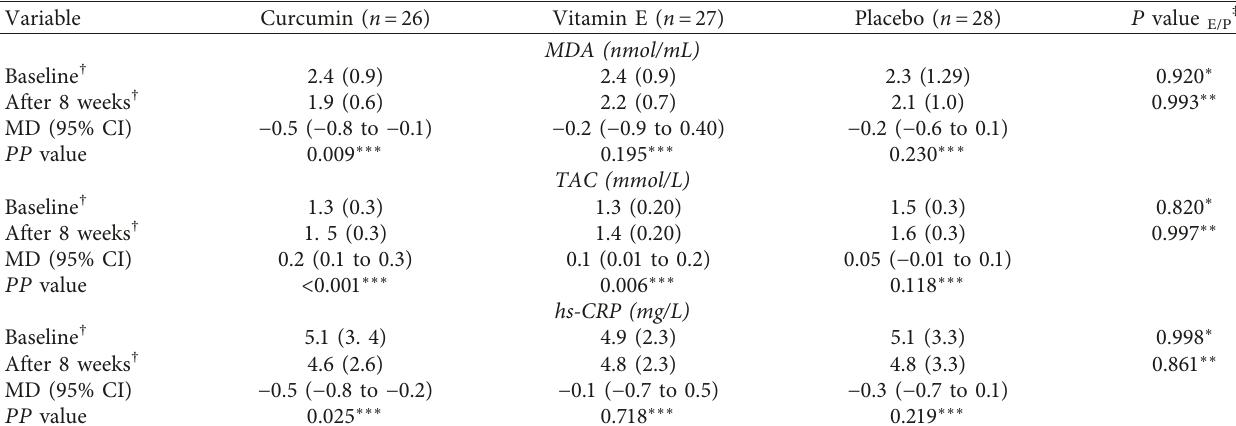
Table 4: Serum levels of MDA, TAC, and hs-CRP among the study